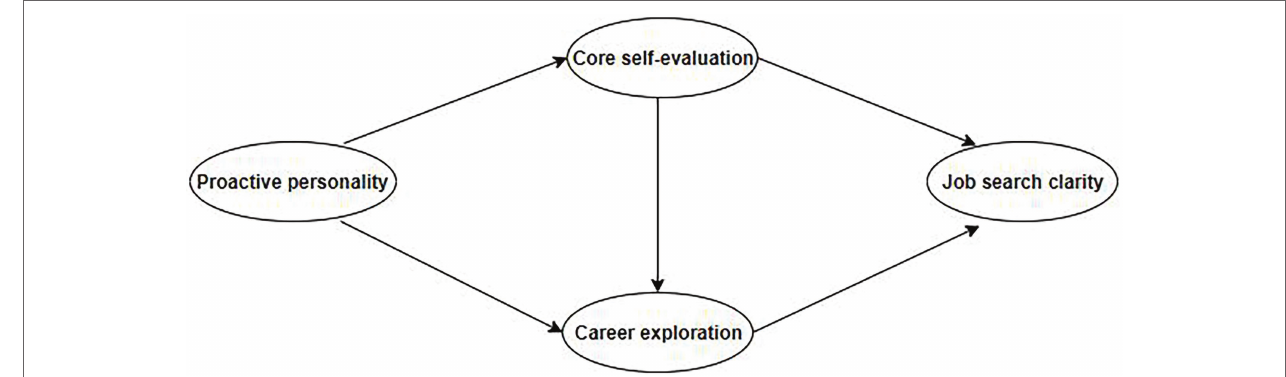
FIGURE 1 | The Hypothesized